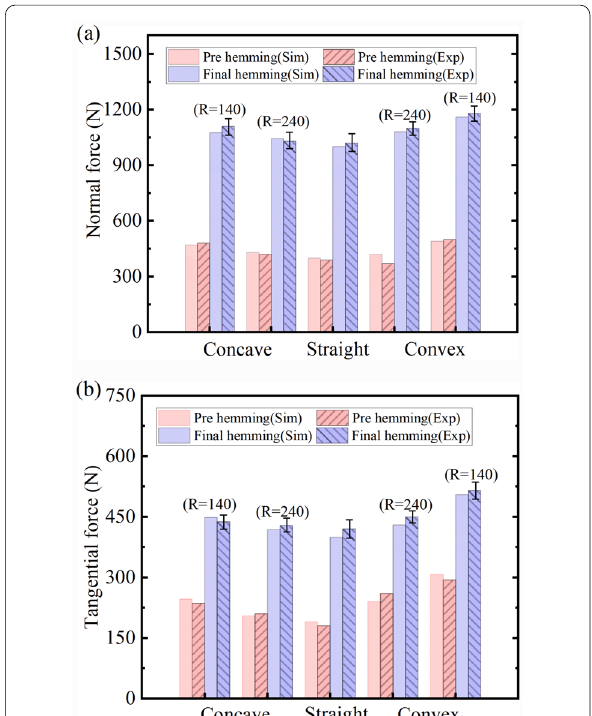
Figure 17 Influence of contour form and radius on external